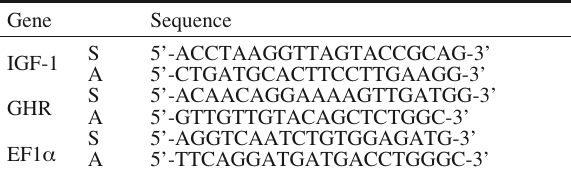
Table 1. – Specific primers used for real-time PCR analyses (S, sense strand; AS, antisense strand).